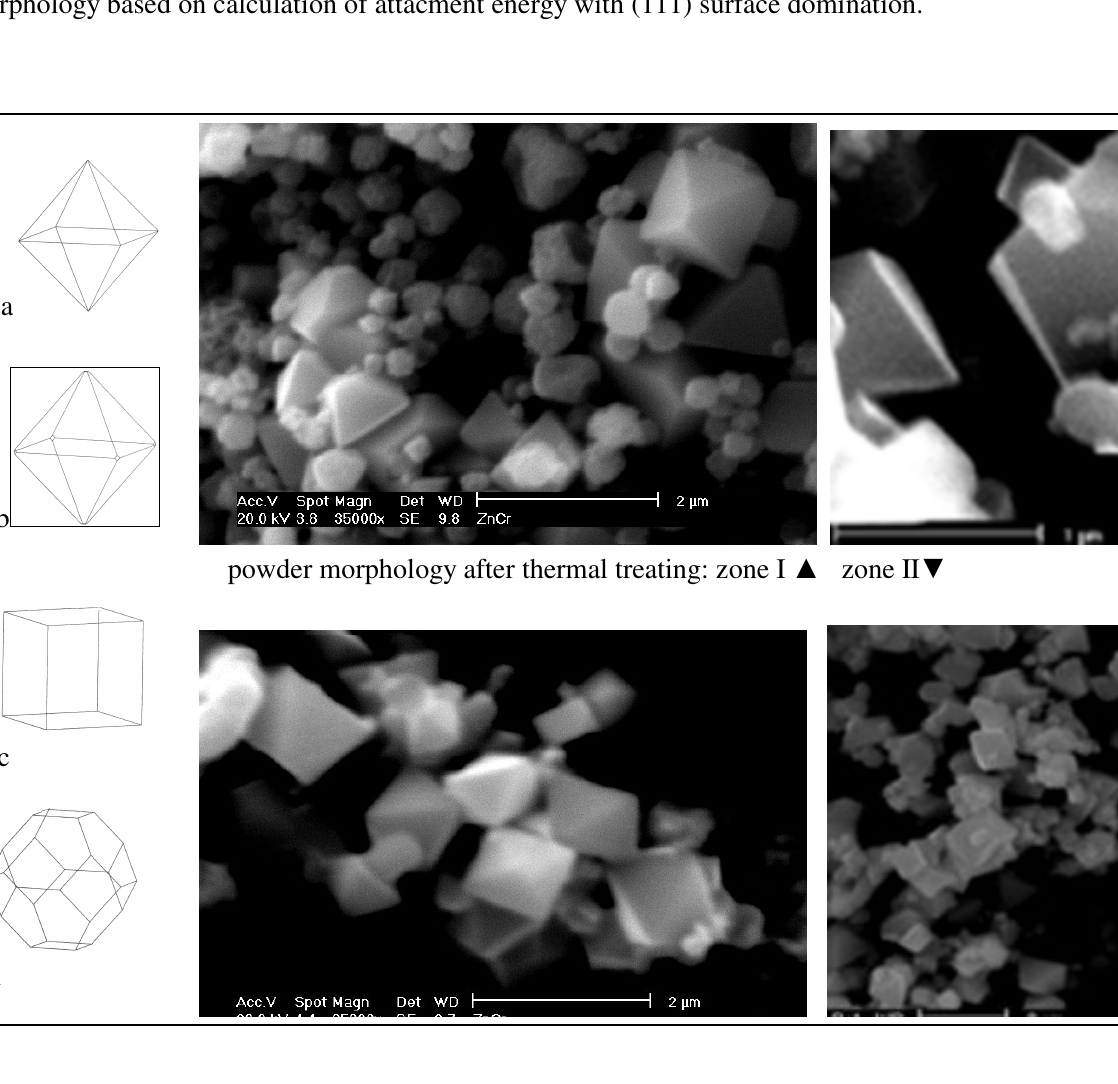
Fig. 4 . Predicted morphology of spinel crystals according to model [6] using: a) unrelaxed and b) relaxed attachment energies; c) unrelaxed and d) relaxed surface energies. Typical particle